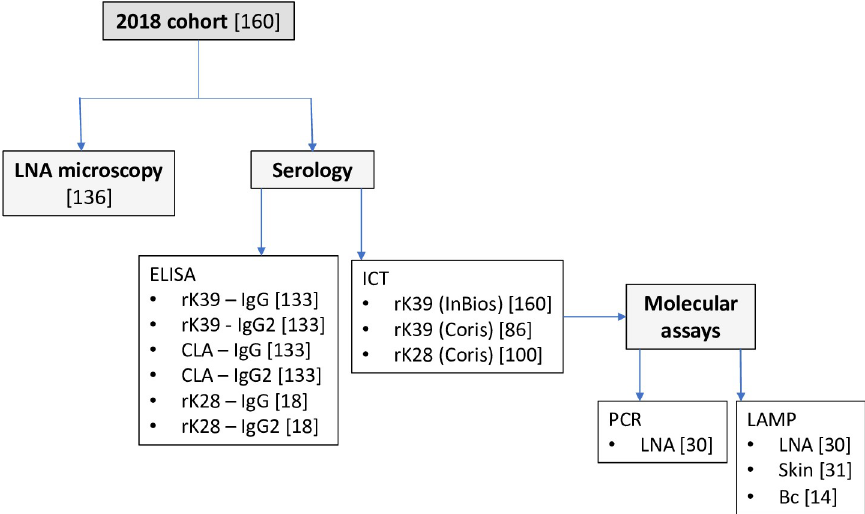
Fig 2. Summary of microscopy, serology and molecular tests applied to the 2018 cohort of 160 dogs (number of dogs to which each test was applied shown in square brackets). Samples were selected for LNA-PCR and LNA-LAMP based on ICT results. Serology and PCR-RFLP with skin broach and LNA samples were also applied to the additional 30 dogs sampled in 2019, and those seropositive for rK28 ICT but negative with rK39 ICT were tested serologically for exposure to six other pathogens (Methods). Bc, buffy coat; CLA, crude lysate antigen; ICT immunochromatographic